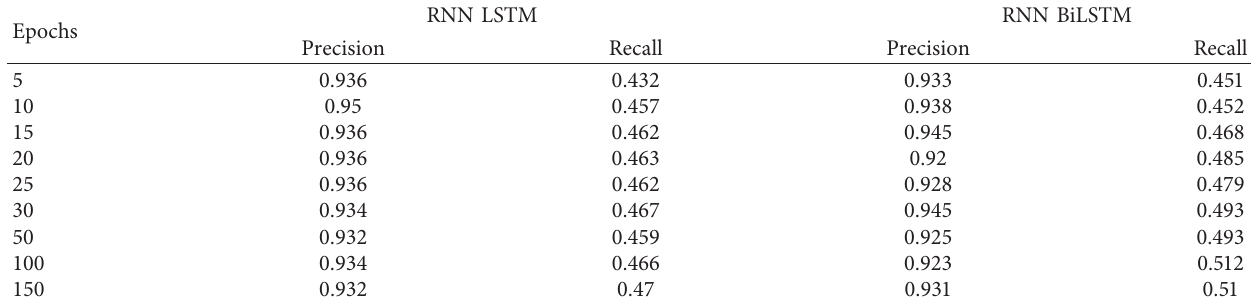
Figure 4: Performance of NN-QuPiD Attack with RNN algorithm and Topic Score feature vector. Table 5: Performance of NN-QuPiD Attack with RNN algorithm and query string feature vector under different Epochs.